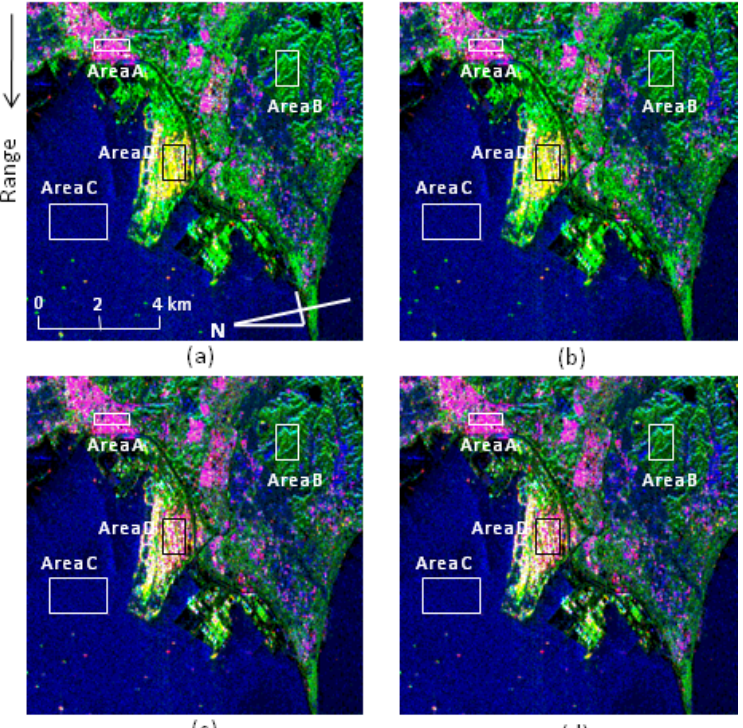
Figure 2. ALOS-PALSAR decomposition images of Tokyo Bay, Japan. The central coordinate of each image is approximately at (139 ◦ 52’E, 35 ◦ 20’N). The upper row ( a , b ): 4-CSPD (helix component excluded). The lower row ( c , d ): 4-CSPD with rotation. The left column (a,c) shows results from coherency matrix and the right column (b,d) shows results from covariance matrix. The red, green, and blue colors represent double-bounce, volume, and surface scattering components respectively. Areas A, B, and C are mostly composed of urban, mountainous, and sea area respectively. Area D is an area which shows remarkable change after